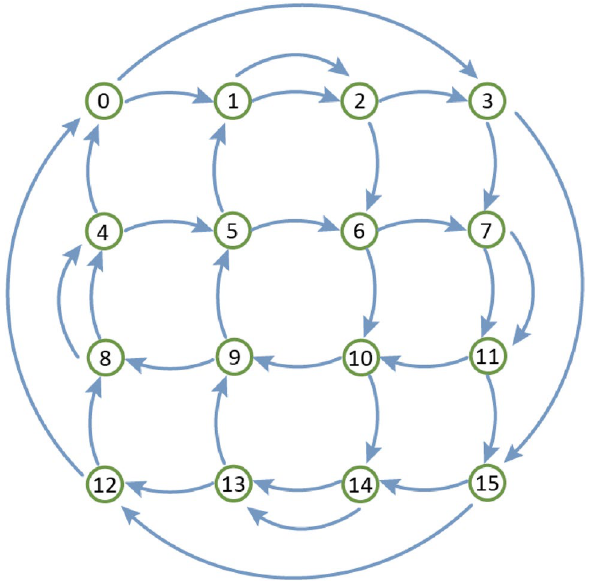
Figure 1. 4-port topology that we used as our reservoir architecture. Shown here is a 16 node layout. Each node has two inputs and two outputs that are connected to other nodes.